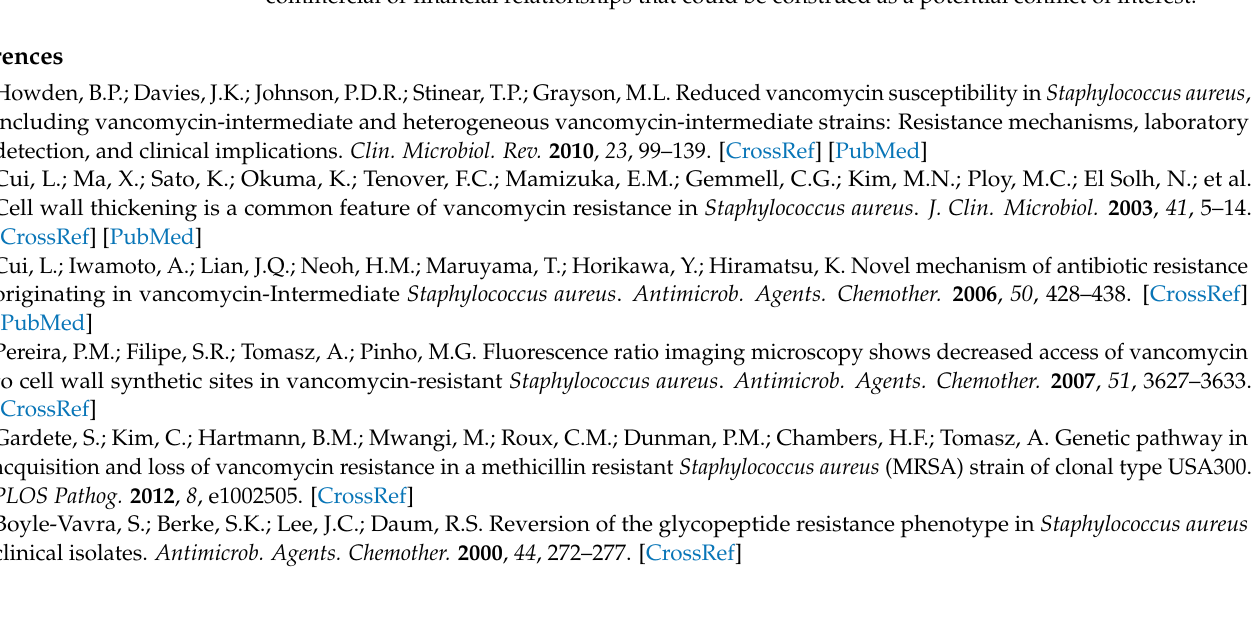
Table S1: DEGs and cis-asRNA in targets putatively related to glycopeptide resistance in VISA CA-MRSA. Table S2: Comparative analysis of the nsSNPs in the intergenic genomic regions in 1R vs.